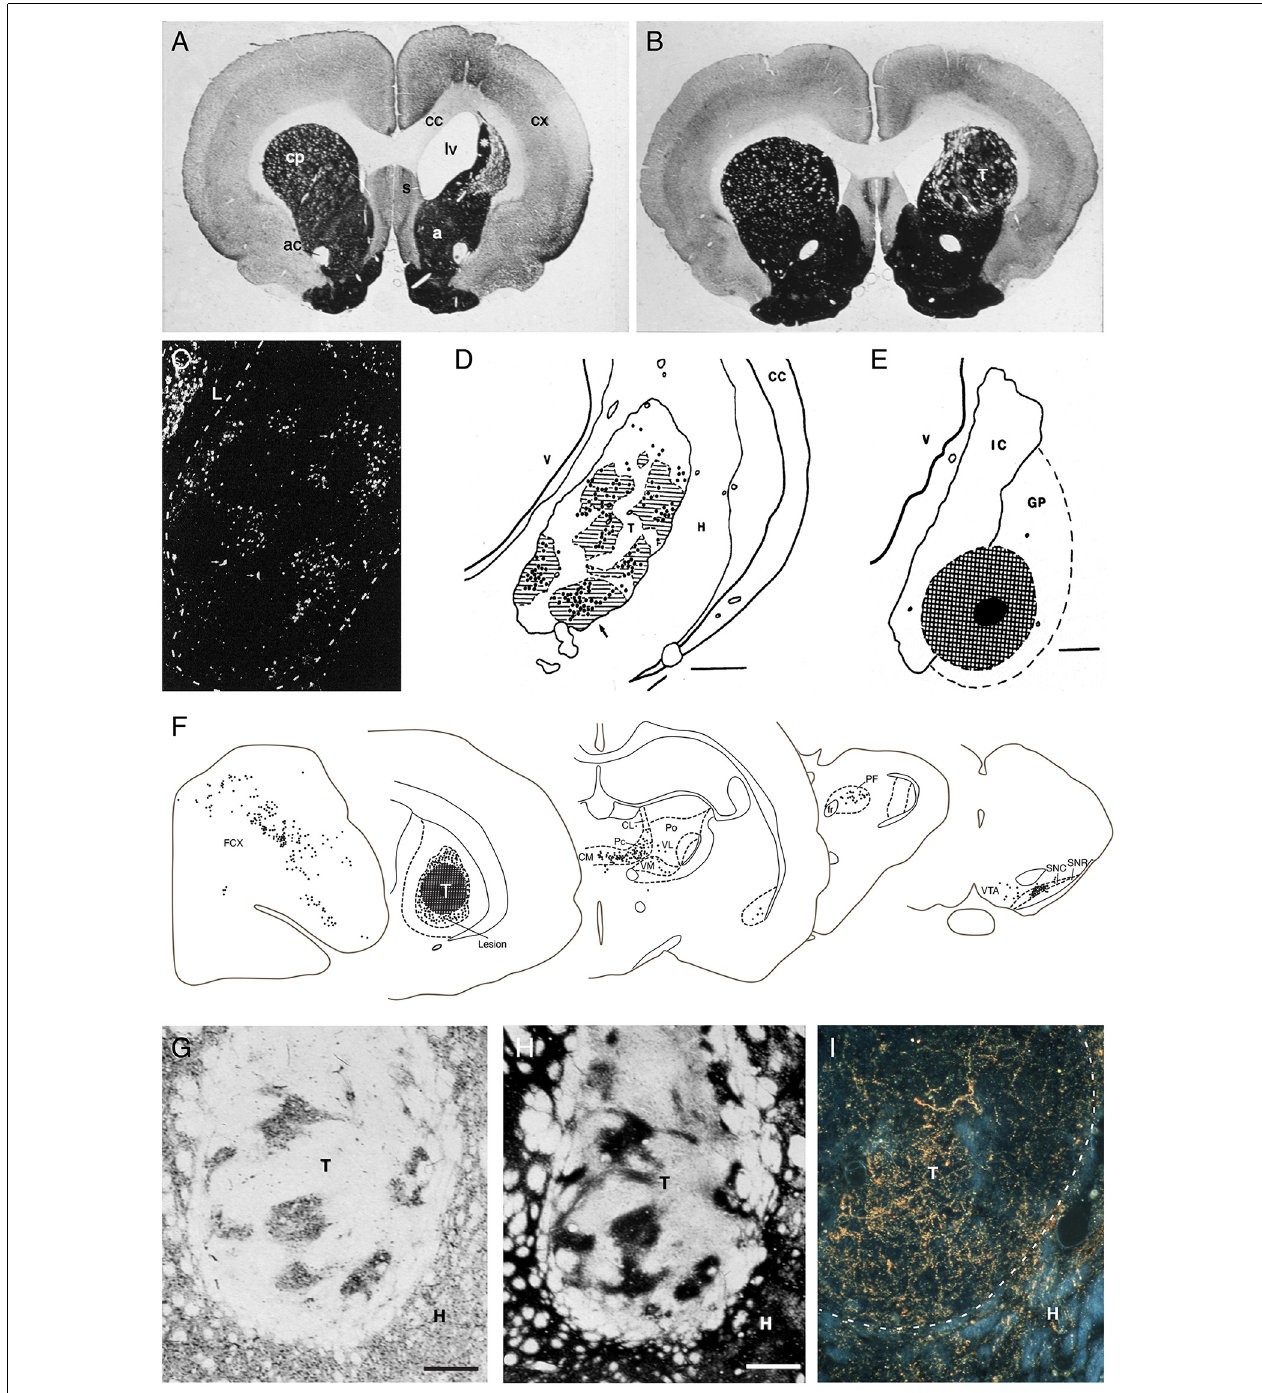
FIGURE 2 | (A,B) The loss of striatal neurons, and the reduction in overall striatal volume, seen in the excitotoxin lesioned striatum (as shown in A ), are largely restored by the transplanted fetal striatal primordium ( B ; AchE stain, 6 months survival. T = transplant). (C–E) Injection of the retrograde axonal tracer FluoroGold into the Globus pallidus (hatched area in E ) results in the labeling of large numbers of DARPP-32+ striatal projection neurons in the graft (bright spots in C ). The vast majority of these are located within the DARPP-32+ patches in the grafts (striped area in D ). (F) Injection of a retrograde axonal tracer into the striatal graft (hatched area, T) reveal extensive afferent inputs from the same regions of the host brain that innervate the striatum in the intact brain, including the frontoparietal cortex (FCX), the intralaminar thalamic nuclei (CL, CM, PF, Pc, Po, VL, VM), and the substantia nigra (SNC), with a distribution that is closely similar to that seen in the intact animal. (G–I) The DARPP-32+ areas of the grafts (G) are densely innervated by TH+ axons from the host nigrostriatal pathway (H) , as well as from the host frontal cortex (labeled with the anterograde tracer PHA-L in I ) adapted from Wictorin et al. (1989b) and Wictorin and Björklund (1989).